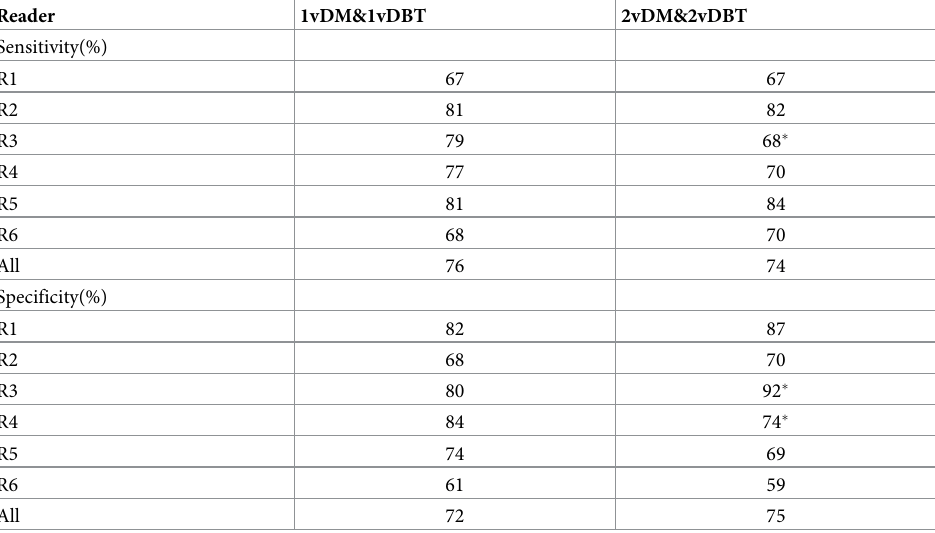
Table 3. Sensitivity and specificity for the average of all readers, using the BI-RADS 1 score of the most suspi- cious finding on each case.